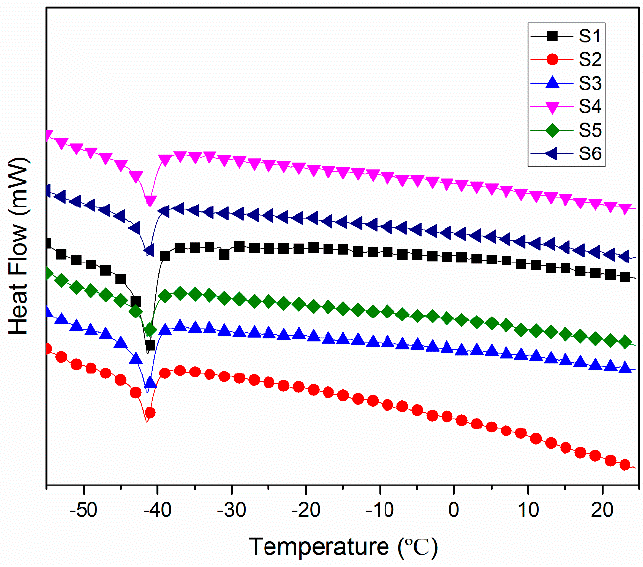
Figure 11. Di ff erential scanning calorimetric curves of polysiloxane foams with di ff erent POSS Figure 11. Differential scanning calorimetric curves of polysiloxane foams with different POSS content.